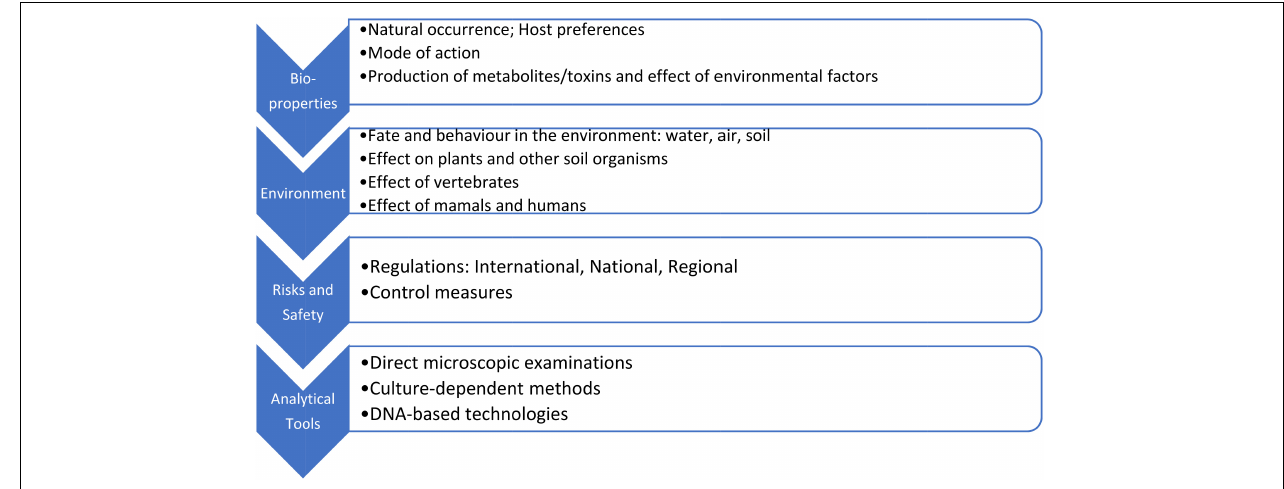
FIGURE 2 | Analytical tools and measures for characterization and monitoring of microorganisms before and after their release in the